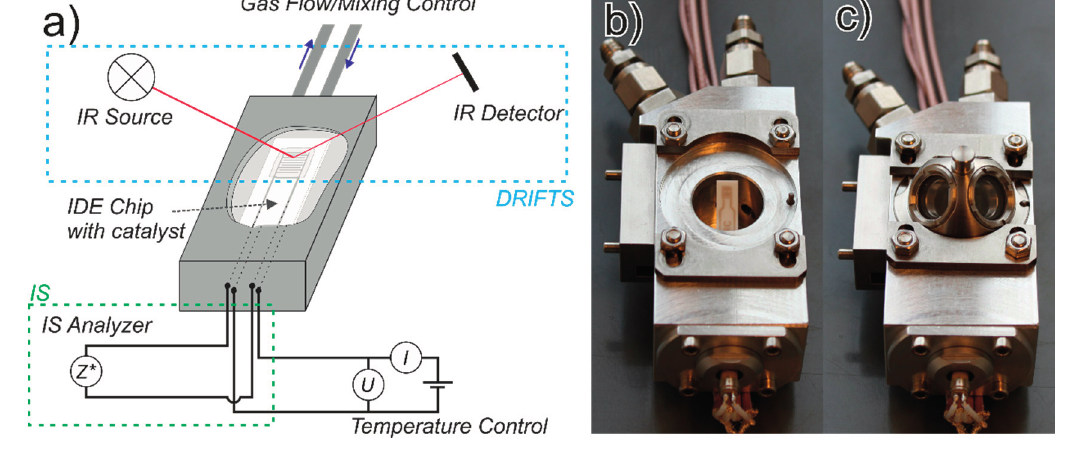
Figure 9. Simultaneous IS and DRIFTS measurements on the same catalyst